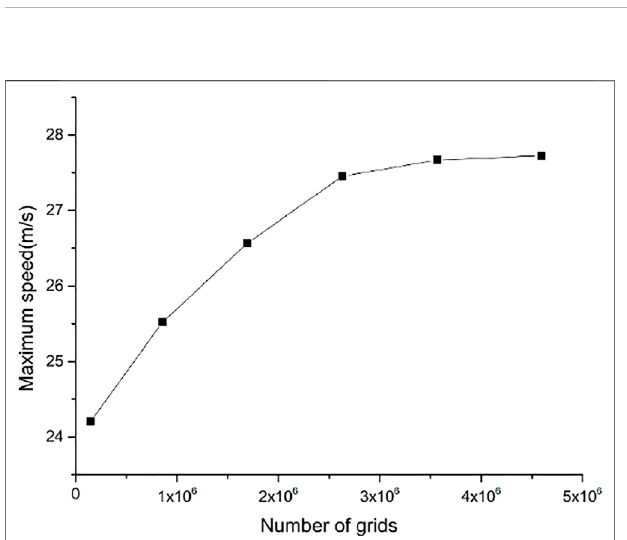
FIGURE 2 | Grid independence veri fi cation.